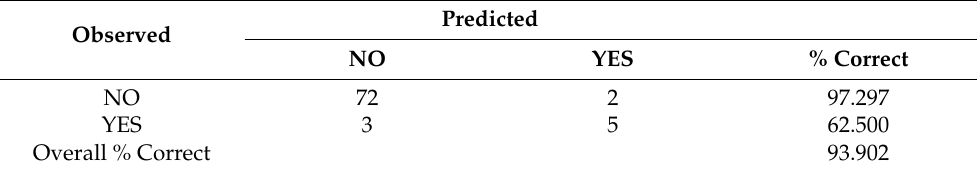
Table 5. Confusion